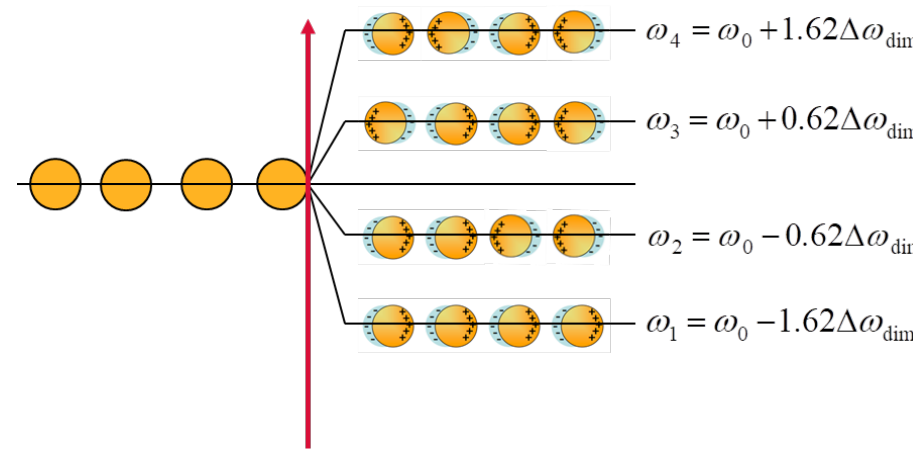
Figure 1. Interaction between 4 NPs in the chain resulting in four different modes.